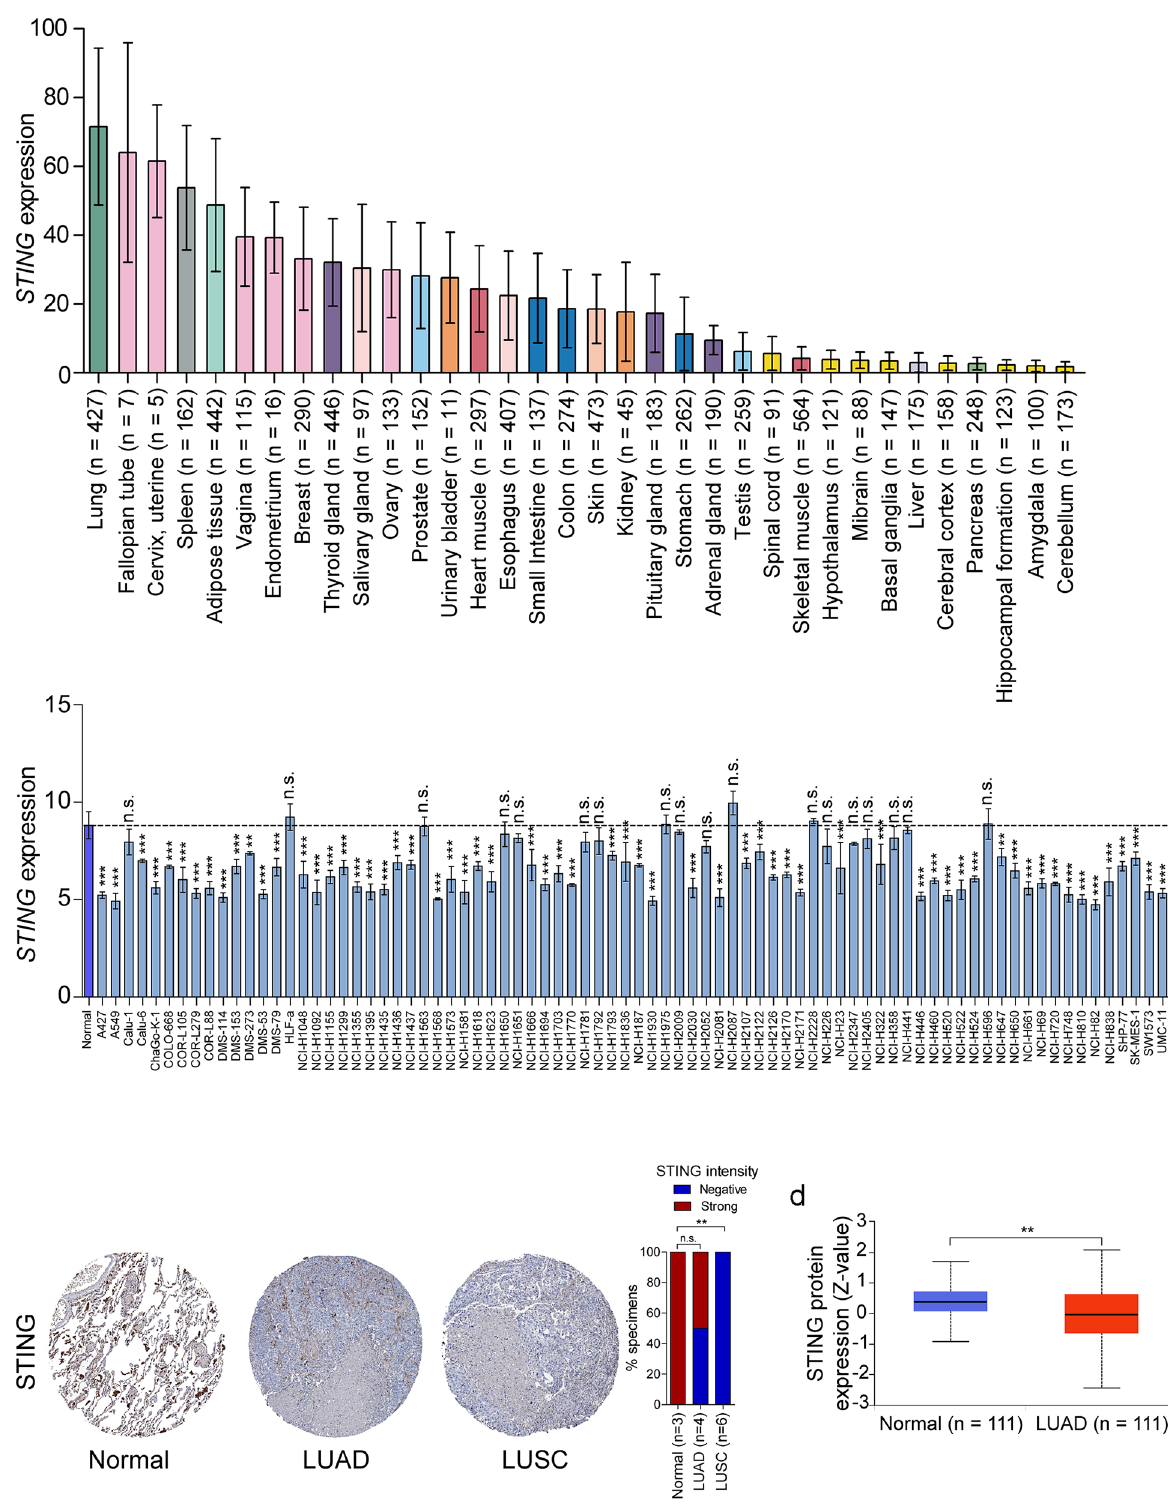
Figure 1. STING is reduced in lung cancer. ( a ) Expression of STING in a variety of human tissues was analyzed in GTEx dataset. ( b ) Expression of STING in a panel of lung cancer cell lines and normal lung tissues (n = 10) was investigated using the MERAV database. ( c ) Representative immunohistochemistry images of STING staining in LUAD, LUSC, and normal lung tissues were obtained from the Human Protein Atlas database (left panel). The percentage of samples with negative or strong STING staining intensity in LUAD, LUSC, and normal lung tissues was quantified (right panel). ( d ) Protein expression of STING in LUAD was obtained from the UALCAN database. Error bars indicate SD. n.s., not significant. ** P < 0.01, *** P <